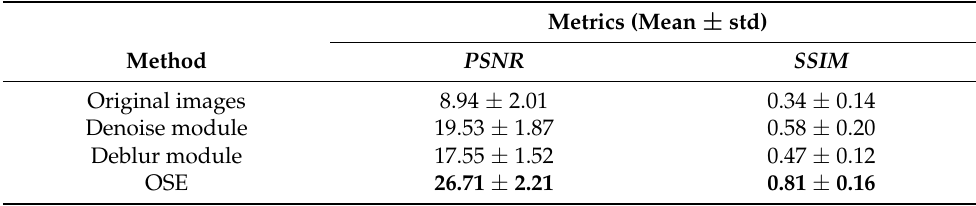
Figure 4. Sample images from the ablation study performed using OCT images from a pork larynx to evaluate the denoise module, the deblur module, and the proposed OSE method. Table 1. Ablation study